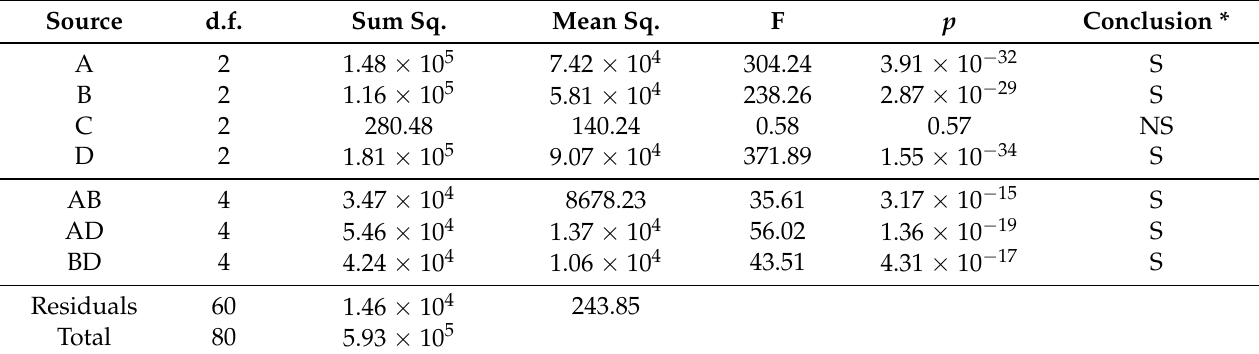
Table 10. Plateau stress results for the reduced model four-factor ANOVA.